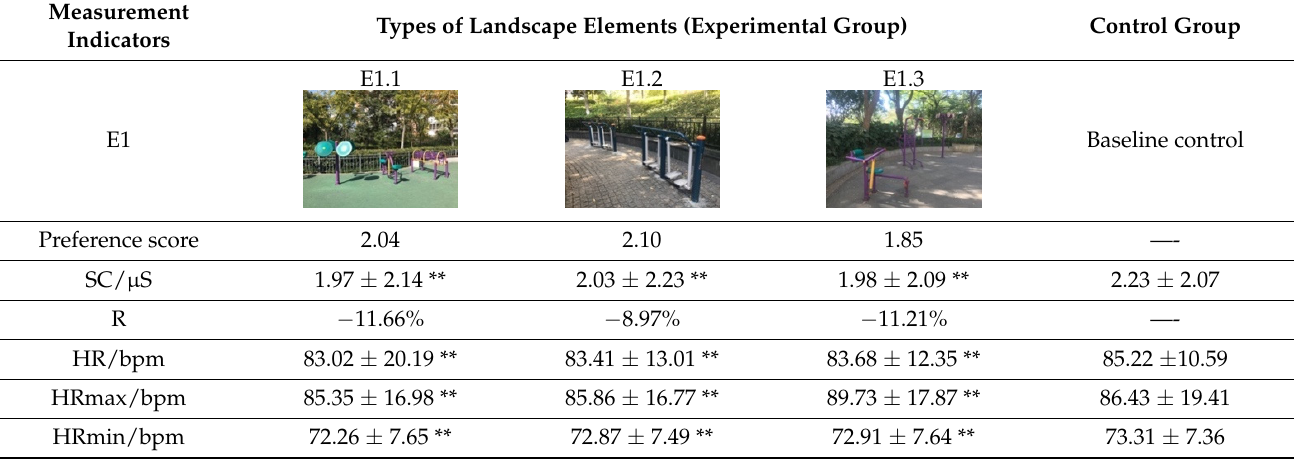
The data in the table are shown as the mean ± standard deviation. * Indicates significance at a level of p < 0.05. ** Indicates significance at a level of p < 0.01.